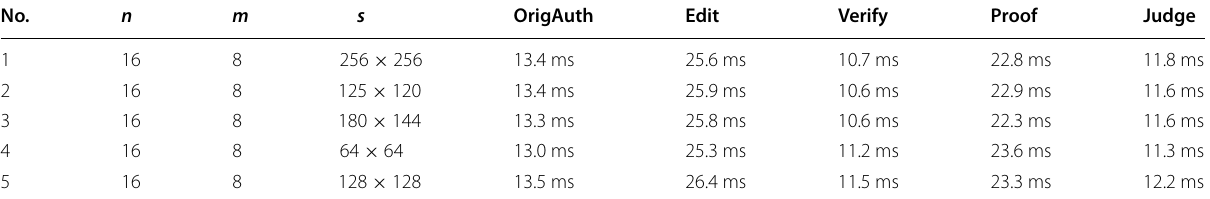
Table 5 The time cost of test images No.